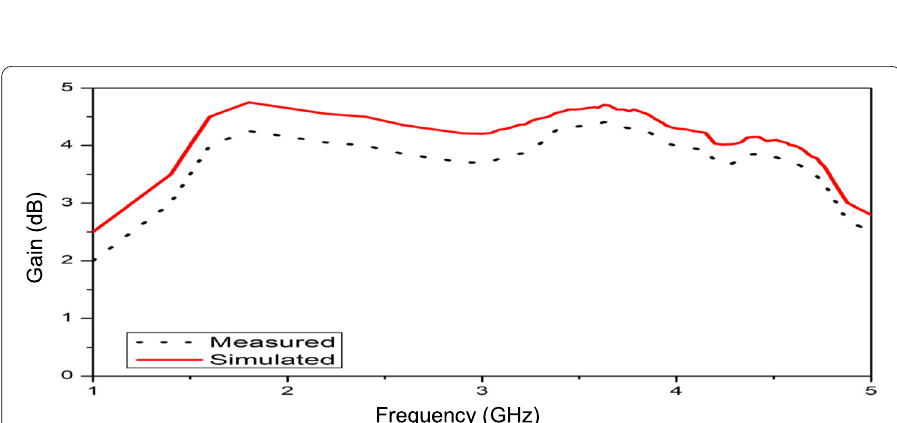
Fig. 15 Simulated and measured gain of proposed antenna with 11 layers of metamaterial